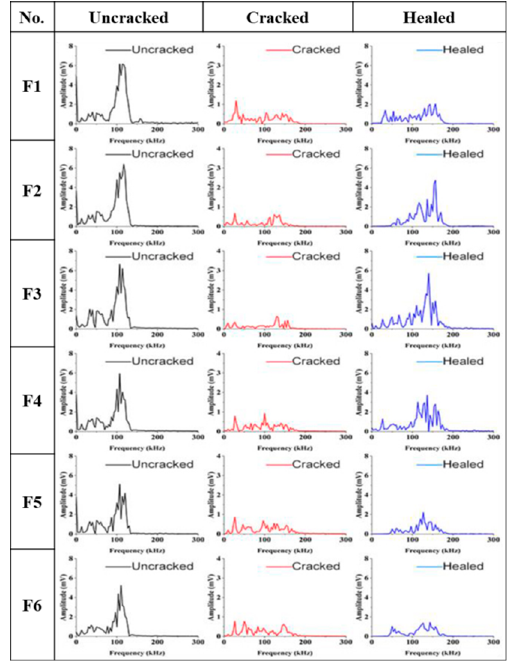
Figure 7. Ultrasonic frequency analysis of samples. (F1–F6 are the group numbers of cement with the average size 22.82 µ m, 29.78 µ m, 39.10 µ m 49.96 µ m, 60.51 µ m and 73.60 µ m, particles with the average size 22.82 μ m, 29.78 μ m, 39.10 μ m 49.96 μ m, 60.51 μ m and 73.60 μ m, respectively.).